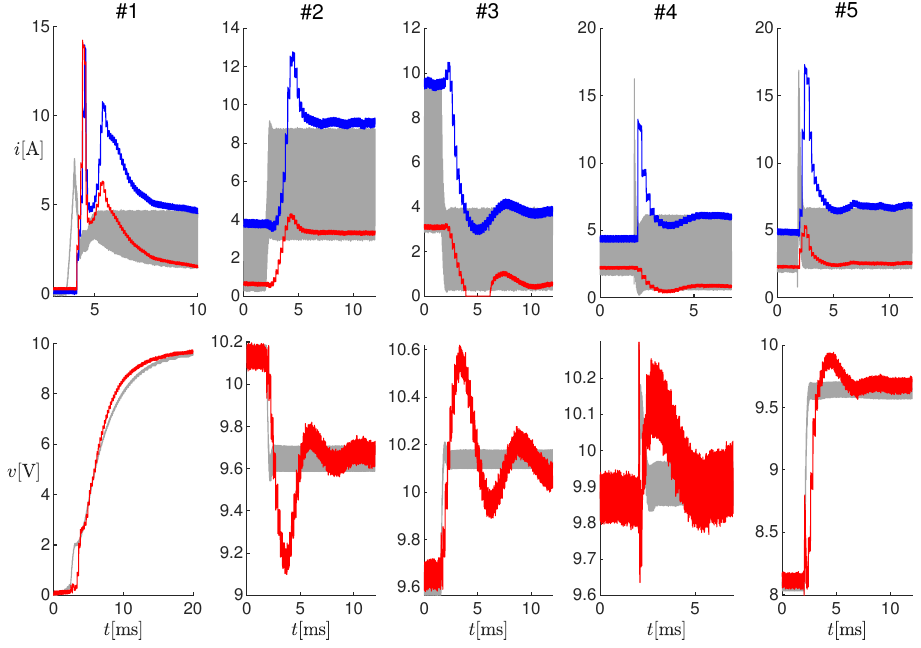
Figure 9. Results of online estimations on Tests #1-#5 (see Table 3). Top panels: measured current (gray curves) and estimated values ˆ ı k (red curves) and ˆ ı (cid:48) (blue curves). Bottom panel: measured output k voltage (gray curves) and estimated value ˆ v k (red curves).